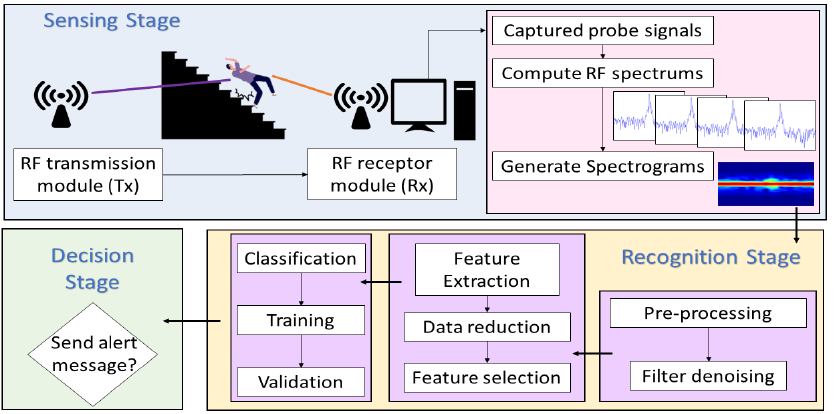
Figure 1. General diagram of a fall detection system based on radio frequency